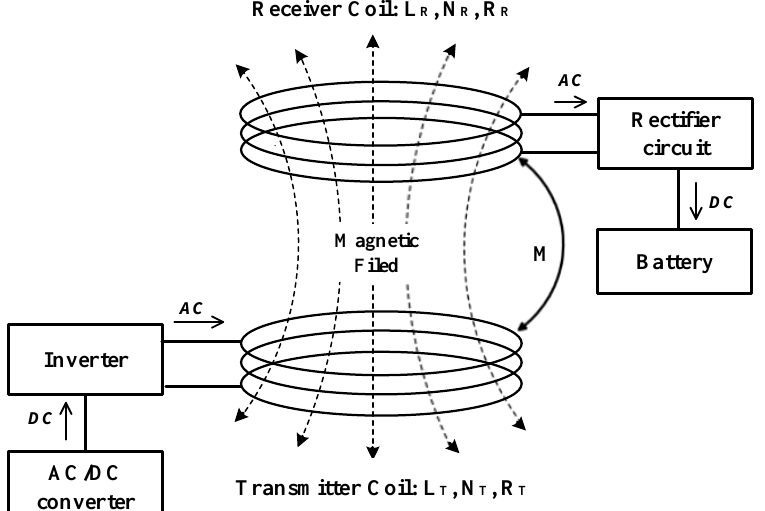
Figure 5. Typical inductive coupling